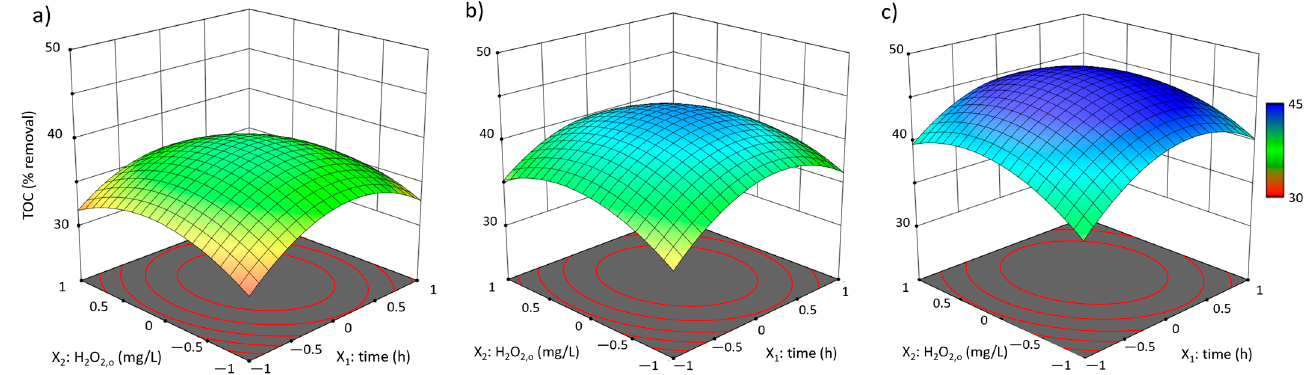
Figure 4. 3D plots of the cross-factor interaction effects between H 2 O 2,o and reaction time (X 1 X 2 ) on TOC removal (Y 1 ) at Fe o3+ (X 3 ) concentration of ( a ) 75 mg/L; ( b ) 200 mg/L; ( c ) 325 mg/L.